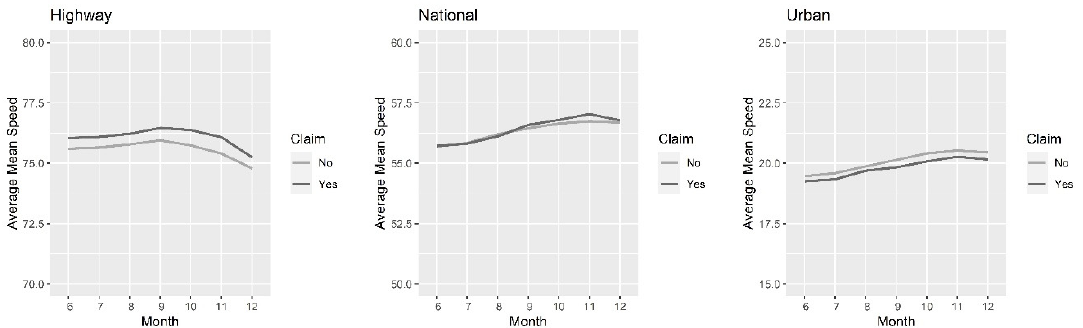
Figure 2. Plots of the average mean speed per individual from month 6 to month 12 in terms of whether or not individuals reported claims at some point over the entire period. From left to right there is a graph for the average mean speed on highways, national roads and urban roads, respectively.